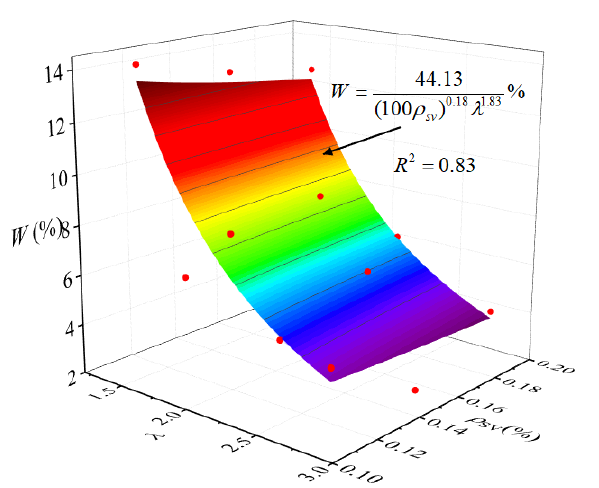
Figure 16. Three-dimensional relationship of W , λ and ρ sv. Equation (1) is applicable to high-temperature beams with a shear span-to-depth ratio less than 3.0. The reduction degree of the indirectly loaded RC beam in Table 3 was calculated using Equation (1), and the comparison between the calculated value and the simulated value is shown in Figure 17. It can be seen from Figure 17 that the simulated value of the indirectly loaded beam after experiencing a high temperature was in good agreement with the calculated value of Equation (1).